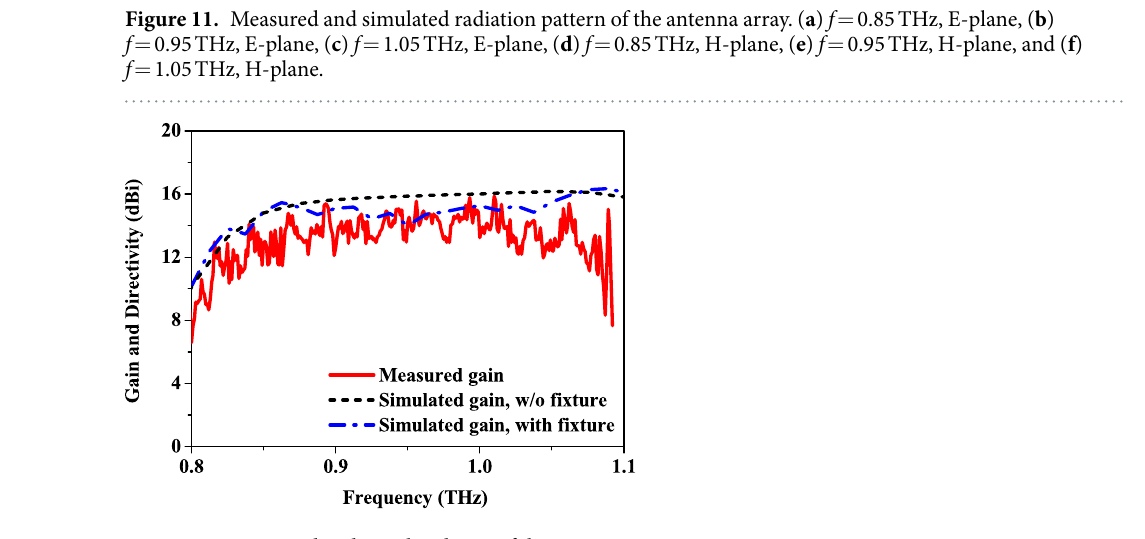
Figure 12. Measured and simulated gain of the antenna